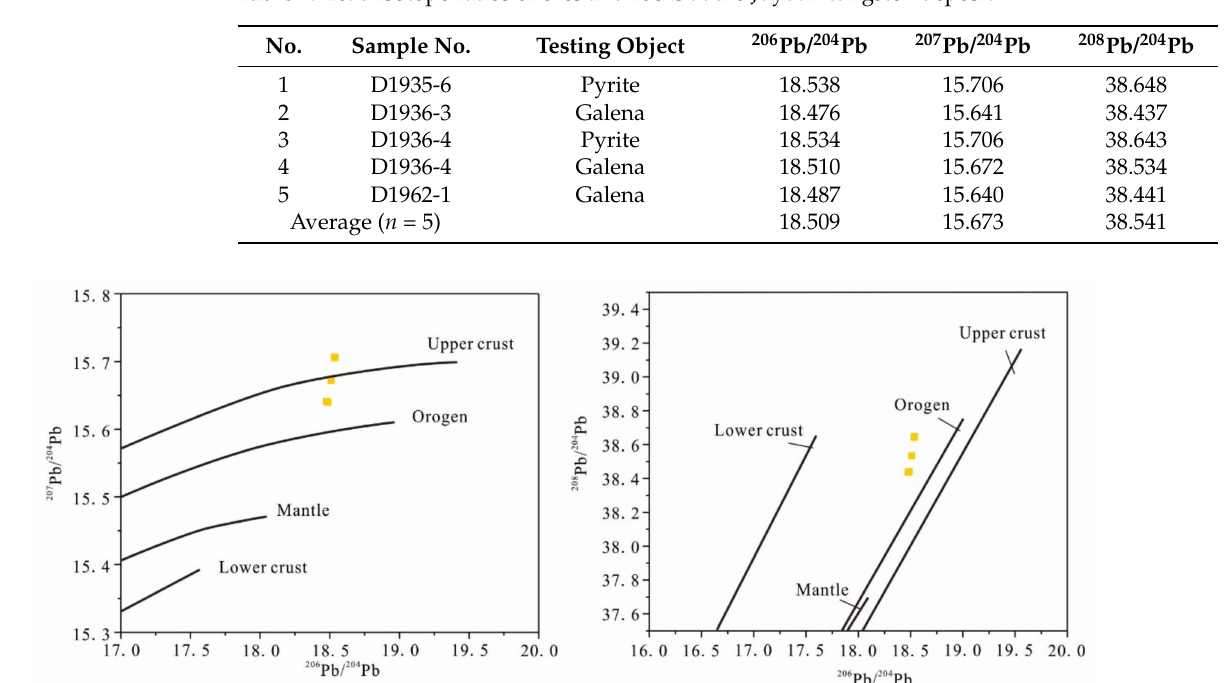
Figure 11. Lead isotopic compositions of the Juyuan deposit. Base map from